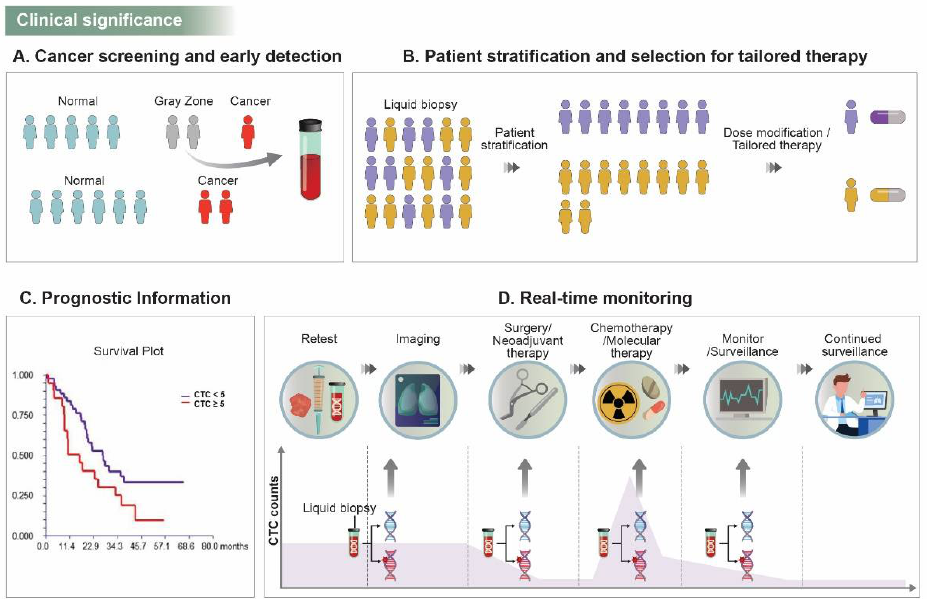
Figure 1. Significance of CTC research in clinical translation. ( A ) CTCs can help in screening and identifying patients who are predisposed to cancer (represented as gray zone) due to familial history, intermediated expression of cancer-associated markers (such as PSA), or other comorbidities, and thereby prevent overtreatment (overdiagnosis) or undertreatment of patients in gray zone. ( B ) Patient stratification based on CTC count or CTC expression of clinically targetable markers can improve patient outcomes by altering the therapeutic strategy and developing more personalized therapy decisions. ( C ) CTC can provide prognostic information on cancer progression or early/late recurrences in different cancer types. ( D ) CTCs allow for real-time monitoring at different stages of cancer treatment, and combined with conventional radiological/histological information can help in treatment decisions while being a tool for continued surveillance in the DFS